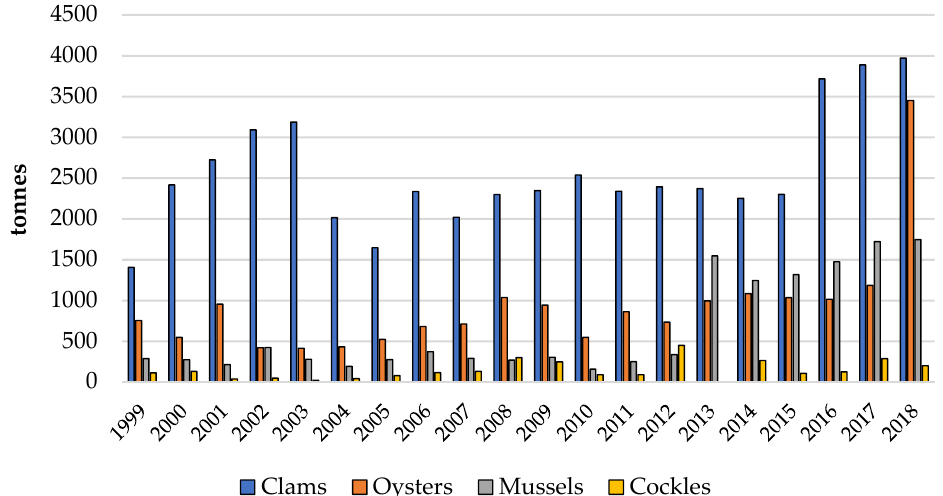
Figure 6. Total aquaculture production in transitional waters of the four main cultured mollusc species in Portugal during the period from 1999 to 2018. Data sources: INE 2000; INE 2002-2020.